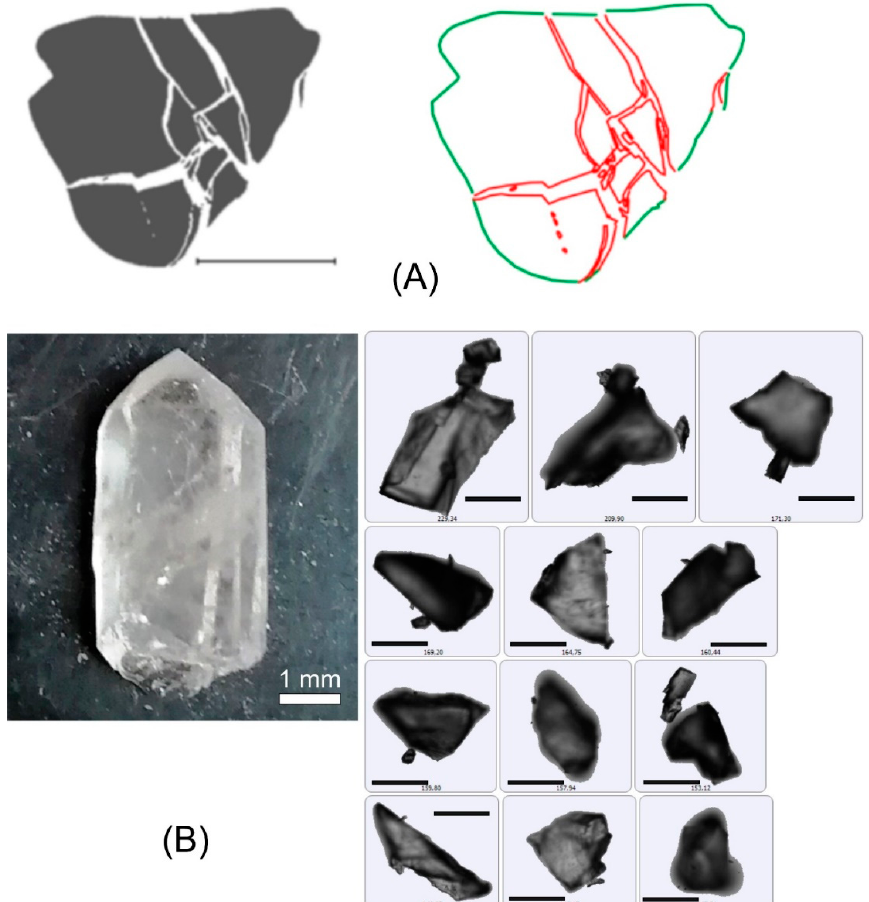
Figure 1. ( A ) Breakage of a grain: on the left, projection images of particles created by the breaking of first grain; on the right, original perimeter (green) and new perimeter (red). ( B ) On the left, the image of the original crystal fragment, 207 mg in weight; on the right, the 12 largest fragments of the left crystal; each fragment of the crystal, from 0.3 mm to 1 μ m, was analyzed from the morphological and dimensional point; in total, the left crystal produced over 320,000 fragments; the black barindicates 150 μ m